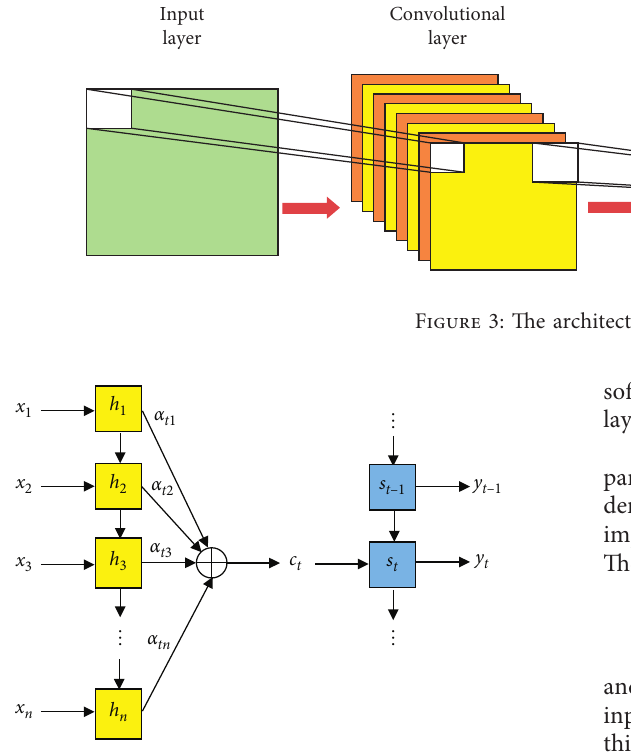
Figure 4: The principle of attention